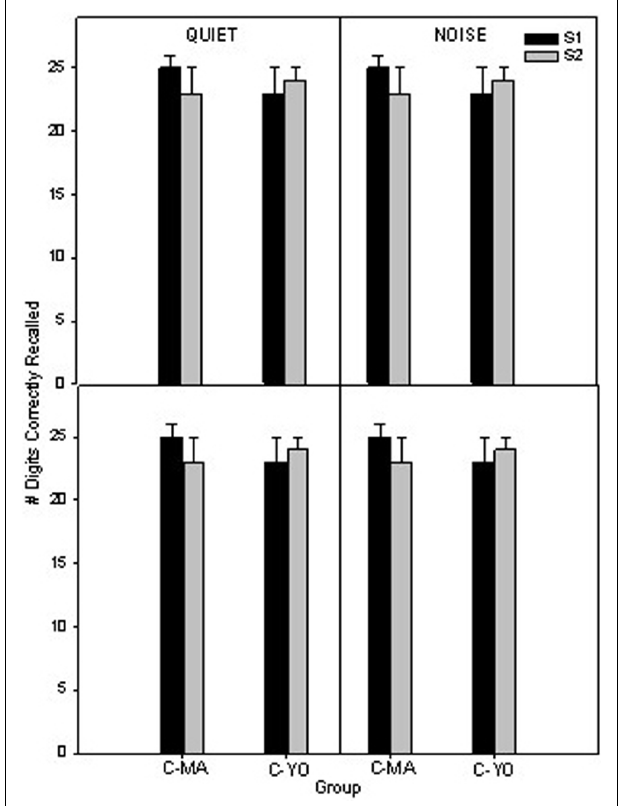
FIGURE 5 | Mean 1-back scores (top) and 2-back scores (bottom) in quiet and noise for the two age-matched control groups (C-MA and C-YO). Error bars represent (cid:6) 1